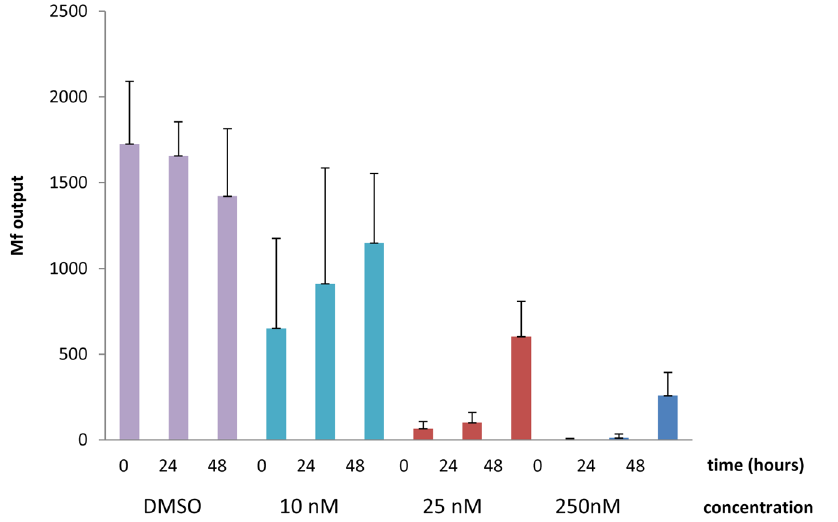
Figure 3. A 24 h exposure to NVP-AUY922 reduces Mf output from female worms. Graph shows the mean ( 6 SD) Mf output from groups of six female B. pahangi worms exposed to 250 nM, 25 nM or 10 nM NVP-AUY922 for a period of 24 h only (time 0). Worms were washed free of drug and cultures continued in medium alone for a further 24 h or 48 h and Mf output quantified. P , 0.05 for 250 nM and 25 nM compared to control at all time points; for 10 nM drug, P , 0.05 for 48 h only. Results shown are representative of two